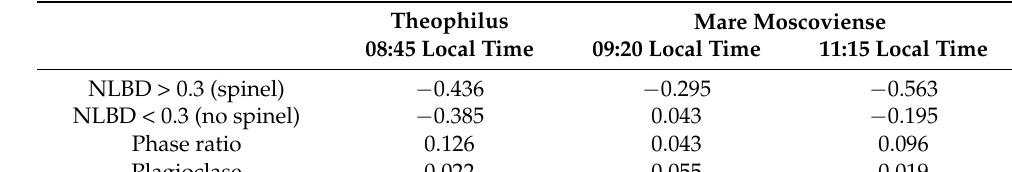
Table 2. Correlation coefficients r for the spinel-rich regions. Dependence of the OHIBD value on the different factors.